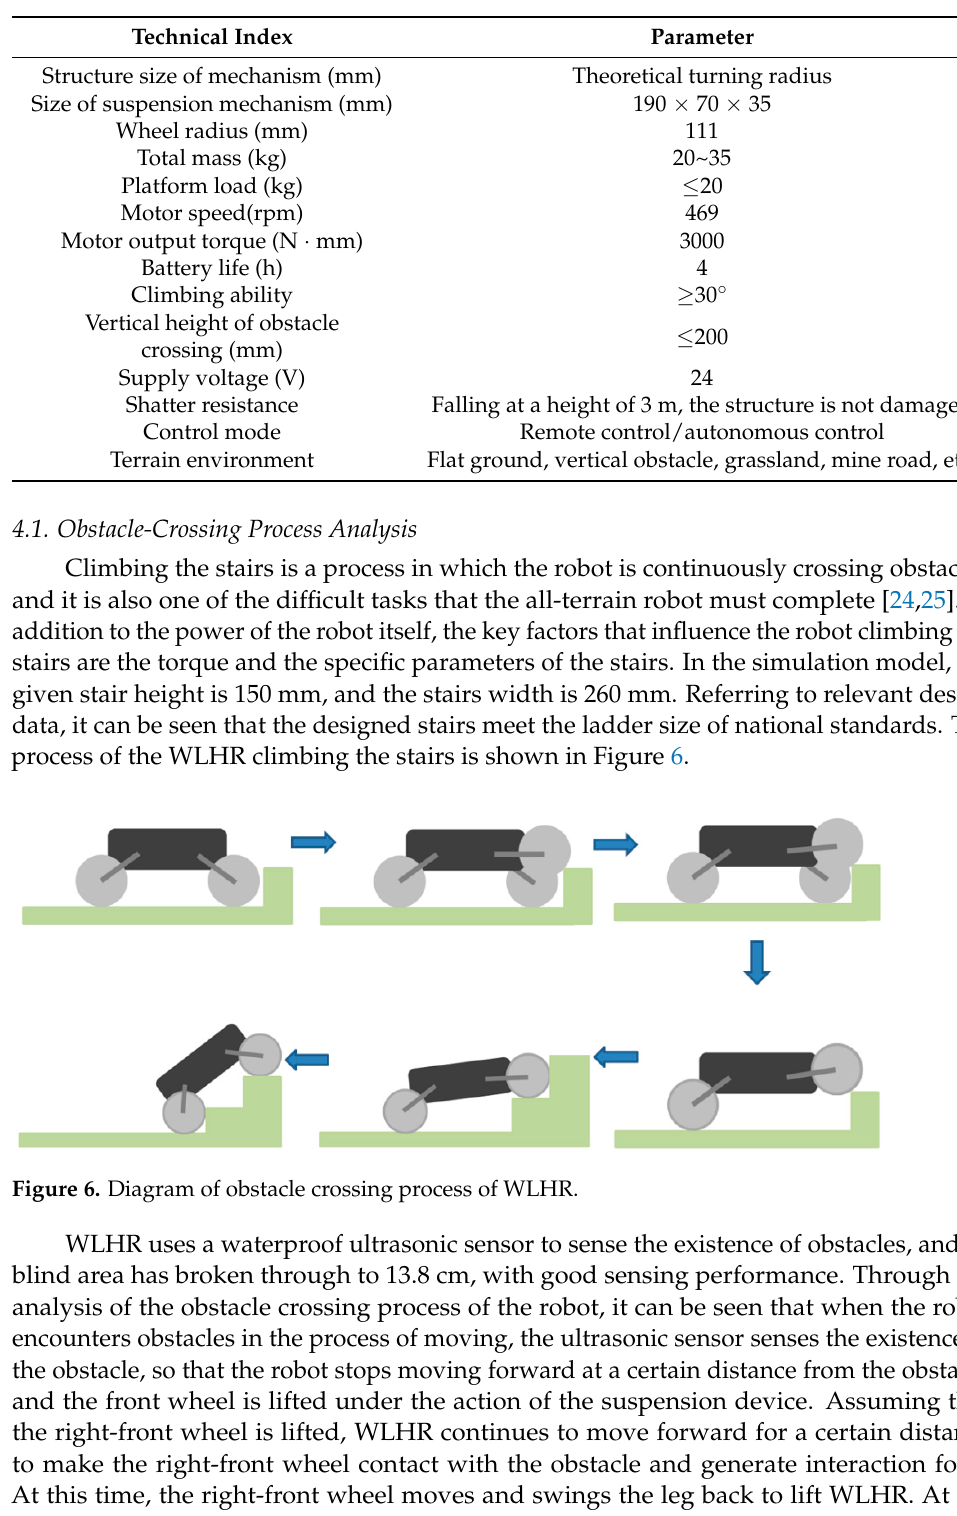
Table 2. Main technical parameters of the mechanism.